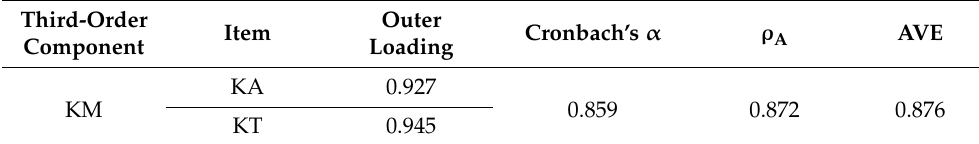
Table 6. Reliability and validity assessment of the third-order component. Third-Order